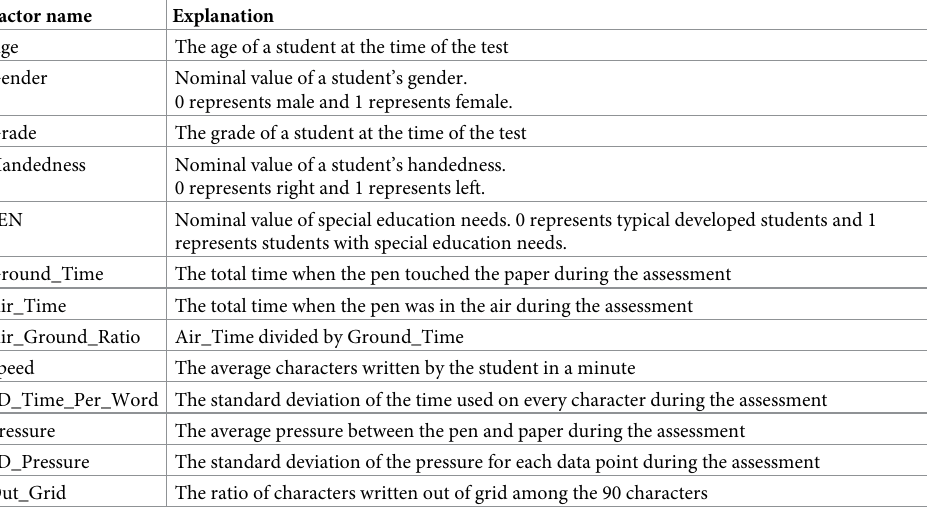
Table 2. Handwriting performance parameters to be entered into the linear regression